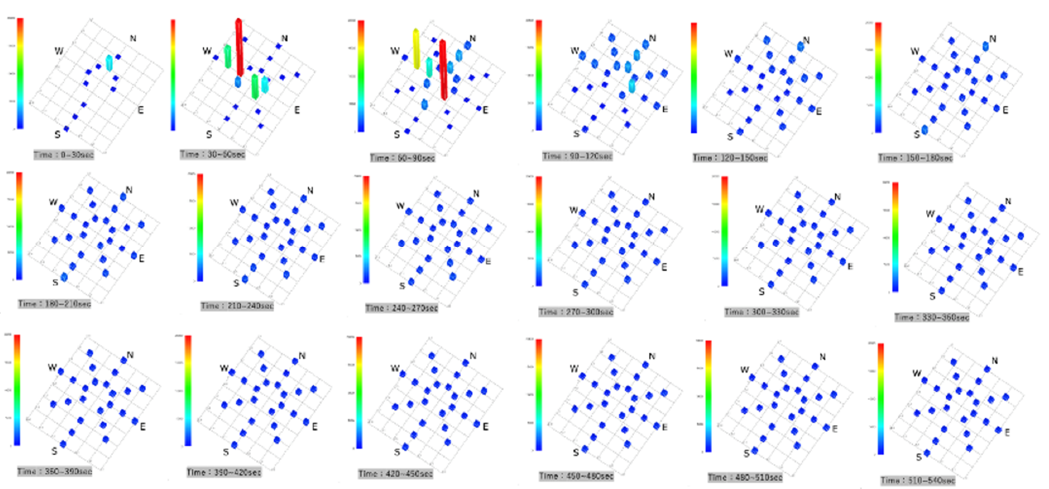
Figure 3. Accumulated images of particles larger than 5 µm visualized with the Parallel Eye H. These particles were captured and observed by the P/Cs. Although the particles >5 µm in size reached a peak at 30–60 s from the start, these particles were low in number and were mostly limited to within 50 cm of the operating sites of the devices. By the end of the experiment, no particles were captured by the P/Cs. In the present experiment, the data were obtained by measuring the number of particles that were less than 5 µm in size.